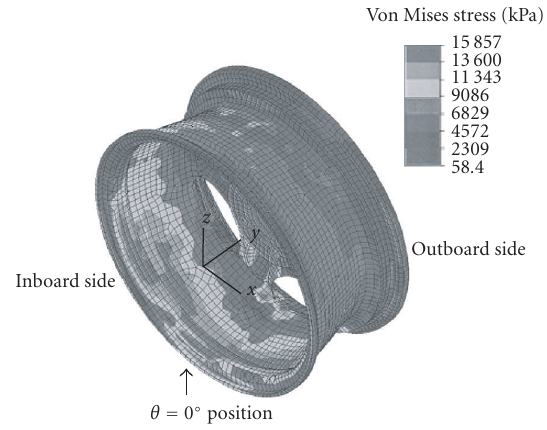
Figure 5: The Von Mises stress distribution in the wheel under 241 kPa pressure.